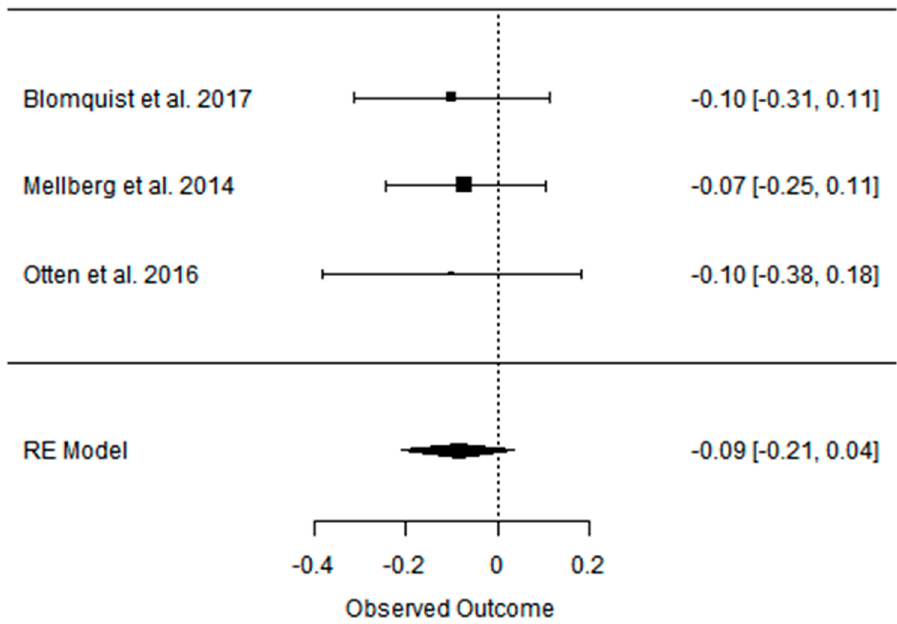
Figure A32. Forest plot of the effect of a PD on LDL-C in the long term (weighted mean difference).